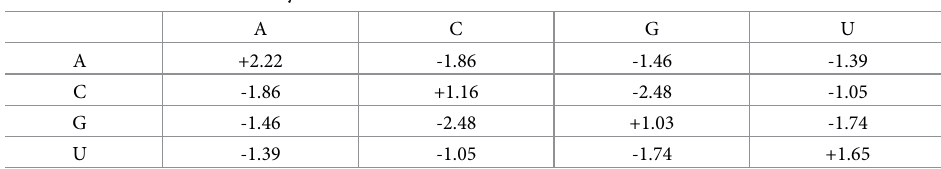
base pairing substitution scores, currently unused by RNAmountAlign